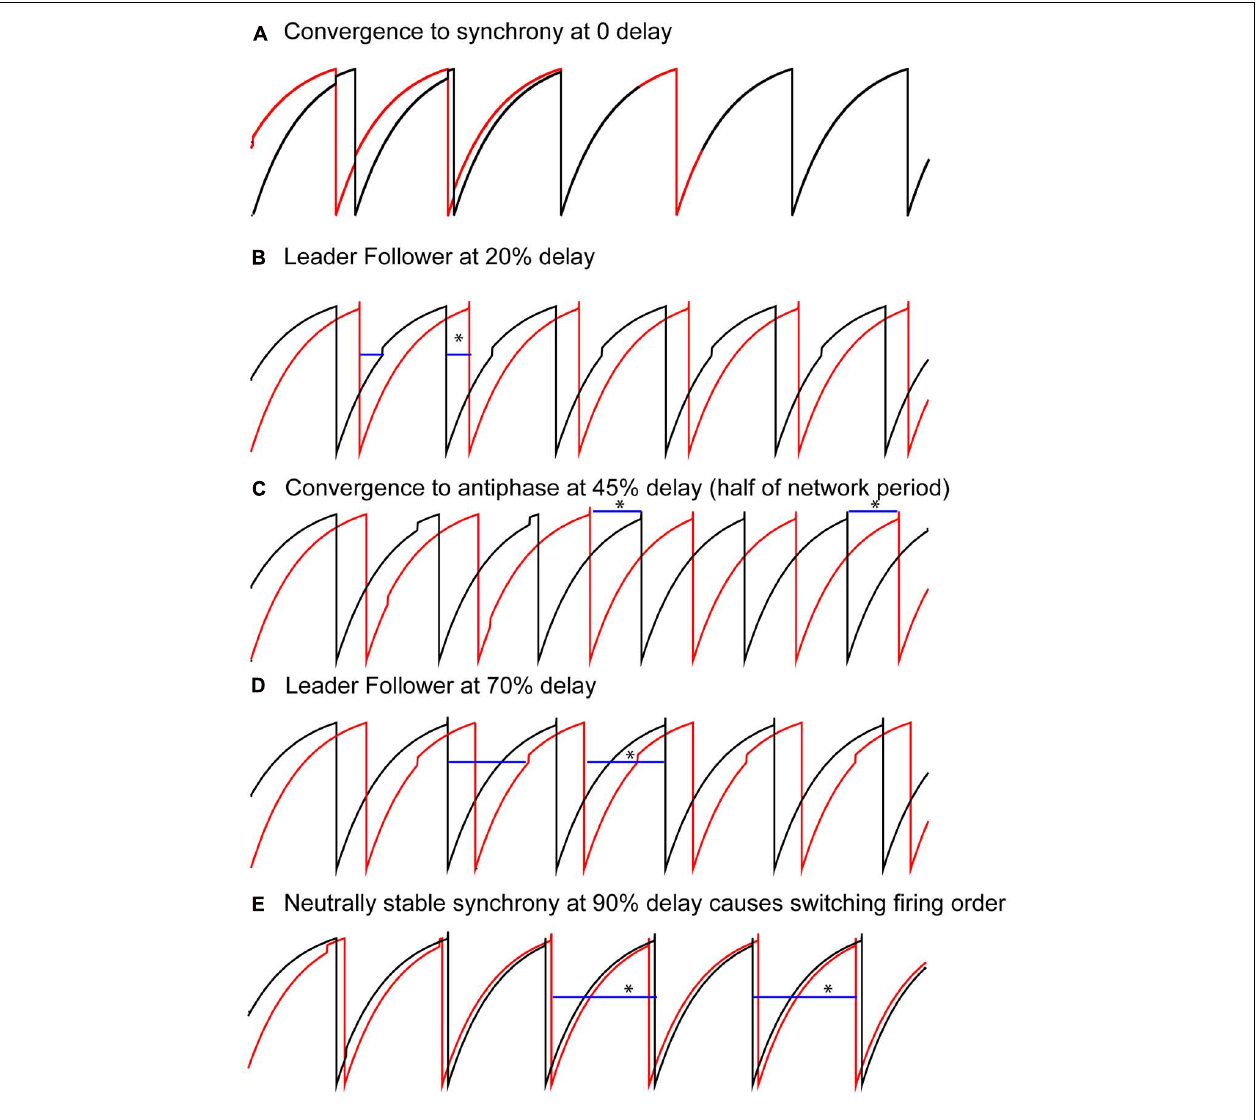
FIGURE 2 |Typical patterns observed in a pair of pulse-coupled LIF oscillators as the delay is varied. Blue horizontal bars show the conduction delay. (A) For short delays, all initial conditions converge to synchrony. (B) For short delays, the shorter time lag (asterisk over blue bar indicating delay) between one neuron (black curve) and the other (red curve) is exactly equal to the delay. Note that the other time lag is not equal to the delay. (C) For midrange delays antiphase is observed in which each time lag (asterisks) is